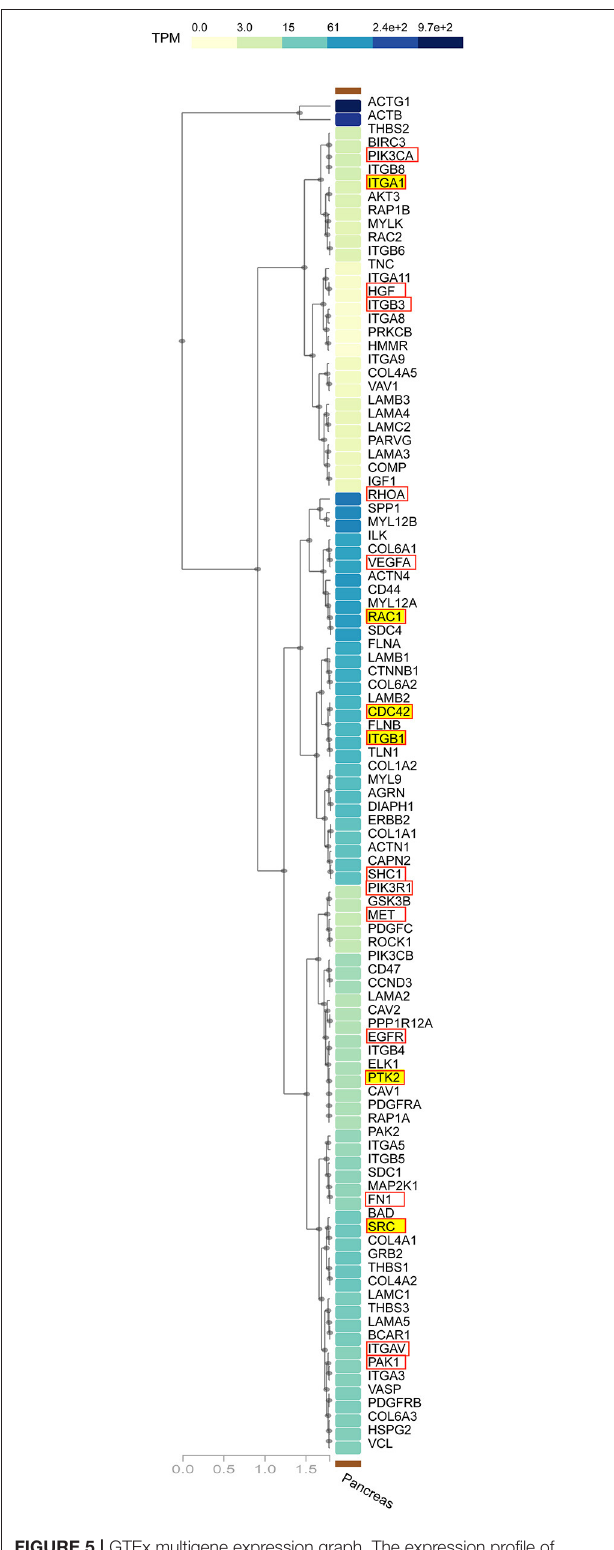
FIGURE 5 | GTEx multigene expression graph. The expression profile of pancreatic cancer (PaCa)-related genes in normal pancreas. The names 6 Hub genes are highlighted with yellow color and of remaining hub genes are highlighted with red box. The graph represents that expression of hub genes are relatively low in normal pancreas